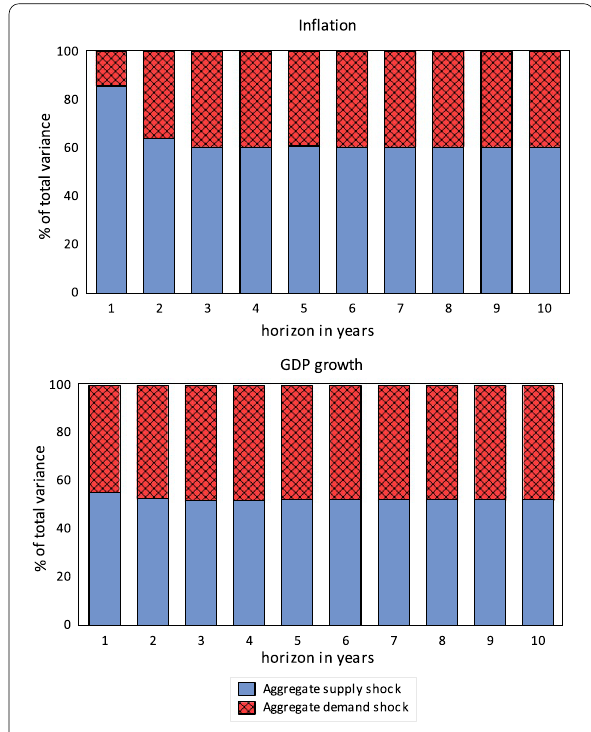
Fig. 6 Variance decompositions, 1855–2015